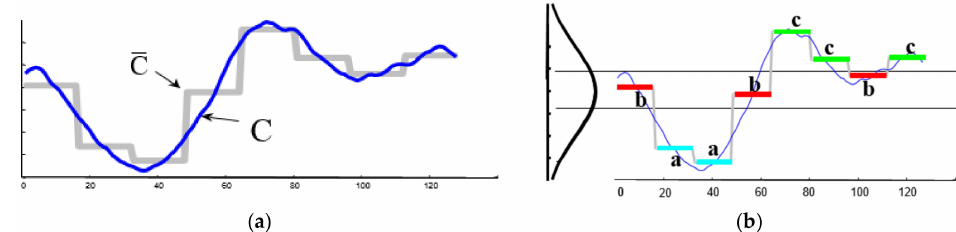
Figure 2. Converting a time series (blue line) to symbolic aggregate approximation (SAX) code using an alphabet of three letters: ( a ) original time series ( C ) and discretization ( C ) for n = 8; ( b ) string (baabccbc) conversion of C , using an alphabet of m = 3 symbols (source: adapted from [27]).